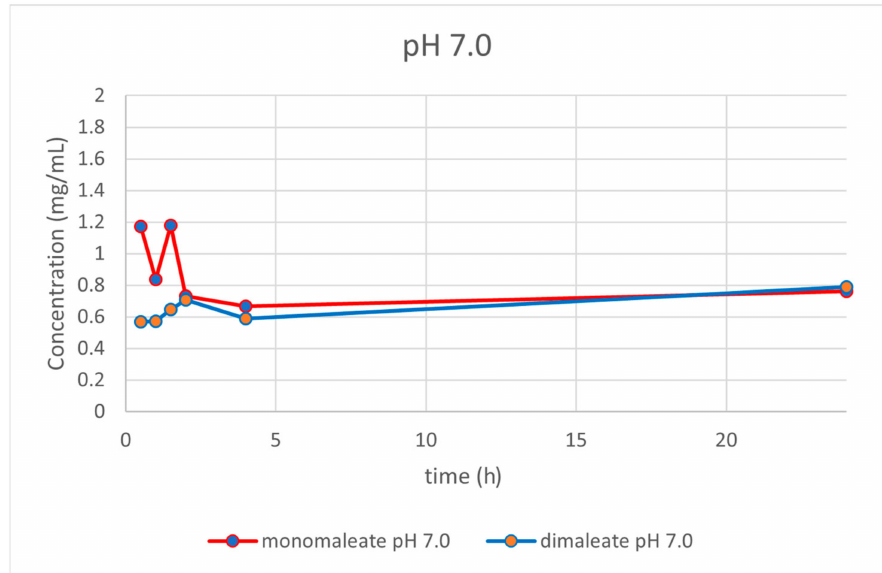
Figure 17. Dissolution testing of glasdegib monomaleate and glasdegib dimaleate at pH =